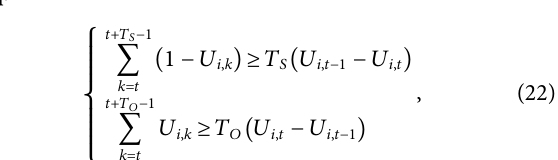
Frontiers in Energy Research |